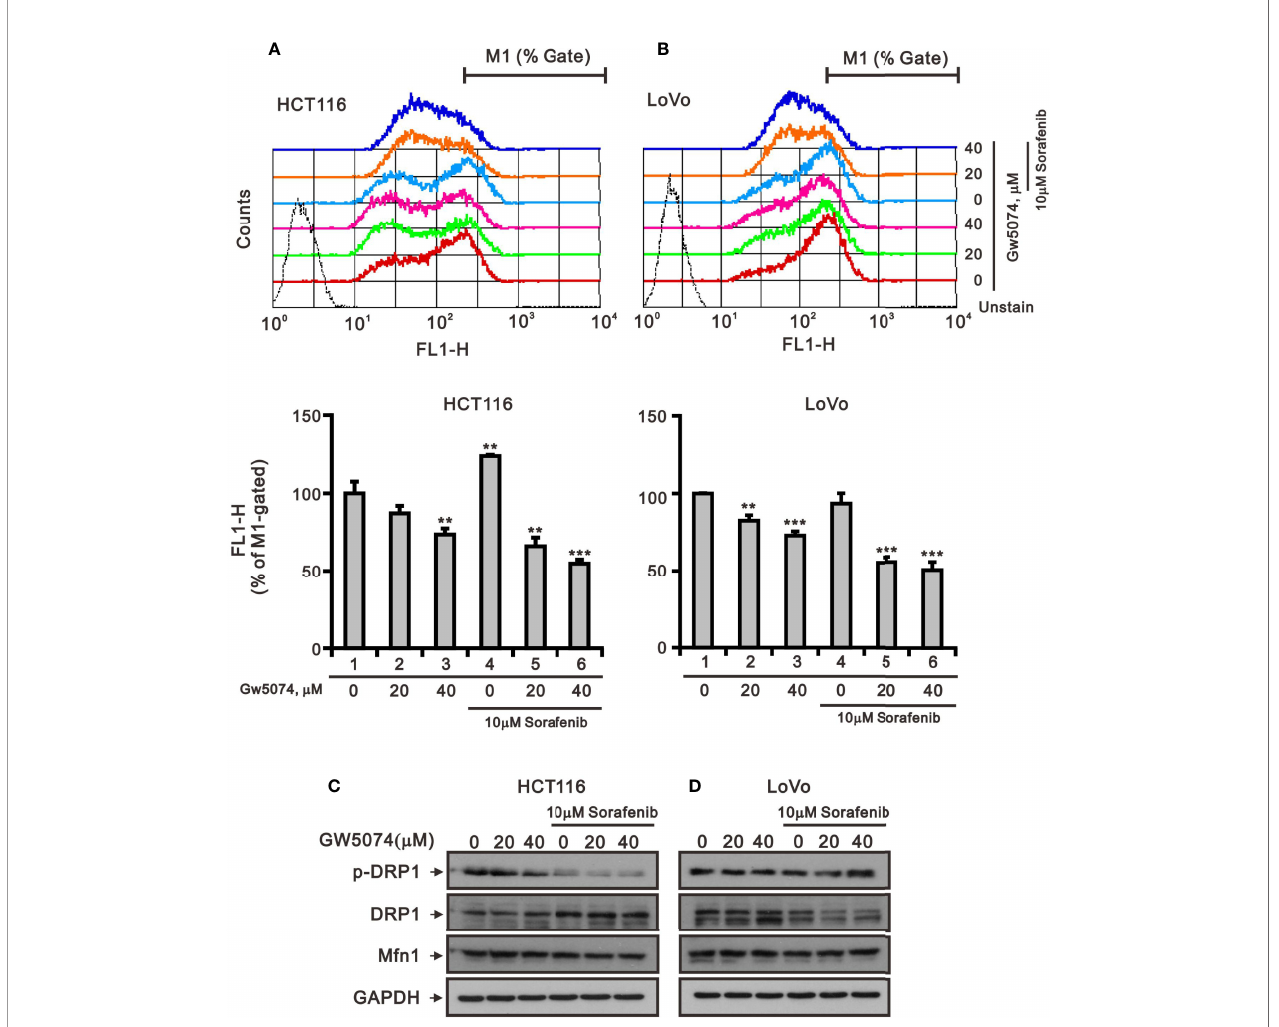
FIGURE 9 | The effects of GW5074 and sorafenib on the mitochondrial fi ssion – fusion transient of HCT116 and LoVo cells. HCT116 (A) and LoVo (B) cells were treated with 0, 20, and 40 µM GW5074 in the absence or presence of 10 µM sorafenib for 24 h, after which the live cells were stained with 100 nM MitoView ™ Green for 15 min at 37°C and assayed using a fl ow cytometer. (C, D) Cell lysates were subjected to Western blotting analysis with antibodies against DRP, p-DRP, and Mfn1. GAPDH is a loading control protein. The results (A, B) are representative of three independent experiments. **p < 0.01 and ***p < 0.001.